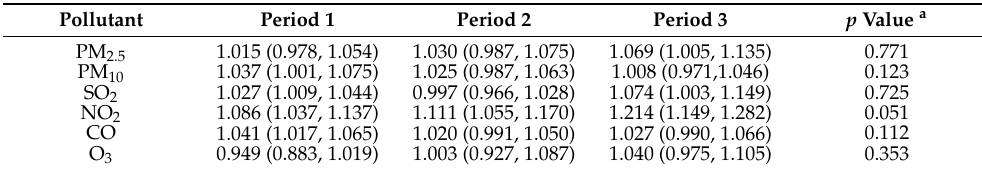
Table 3. Relative risks (RRs) and 95% confidence interval of outpatient visits for AR for an IQR increase of air pollutants at lag0 during specific